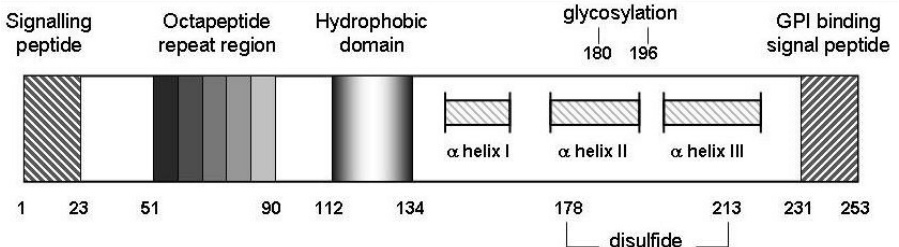
Figure 2. Schematic representation of murine prion protein (PrP C ). Wild-type PrP C contains 4 tandem repeats approximating an octapeptide sequence, an hydrophobic core from amino acids 112 to 134 as well as 2 potential sites for glycosylation at N residues 180 and 196. Regions from 145 to 155, 175 to 193 and 200 to 219 from three alpha-helical structures, and helices II and III are disulfide bridged between C residues 178 and 213 [65]. Not to